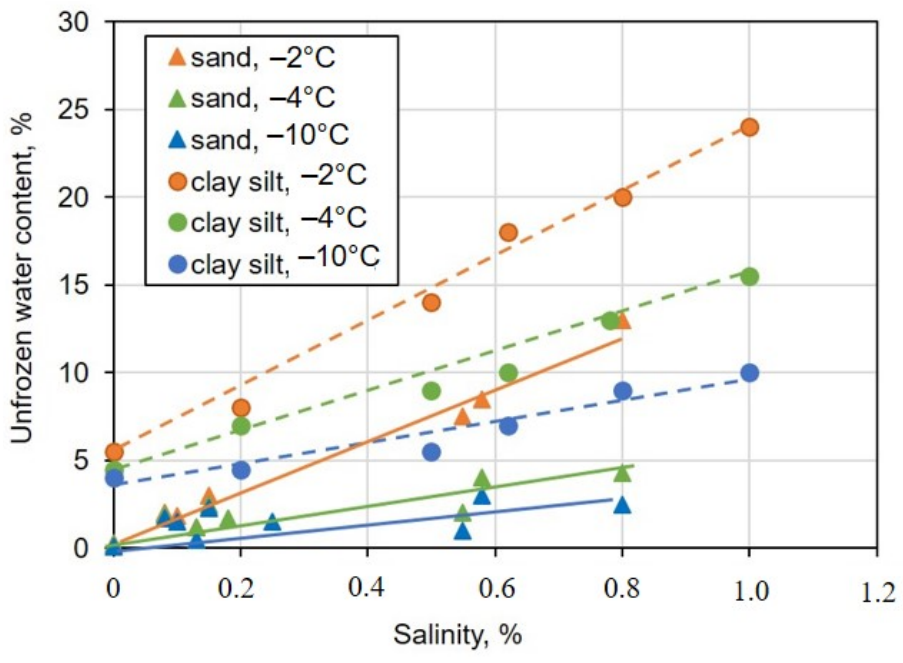
Figure 4. Salinity-dependent unfrozen pore water content in sand and lean clay soils at temperatures of: − 2 °C; − 4 °C; − 10 °C, after Aleksyutina and Motenko [82].